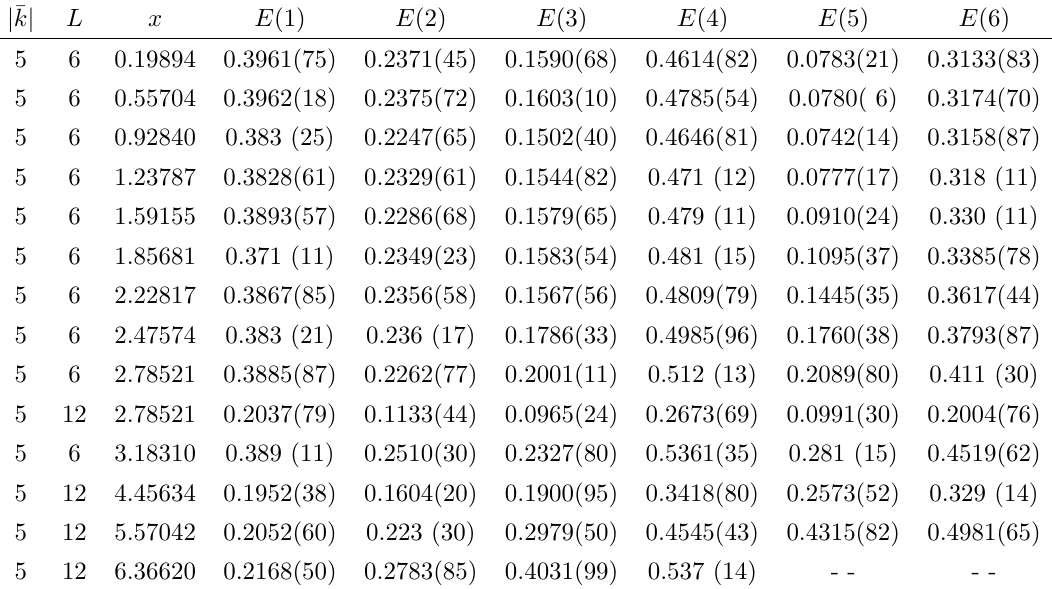
Table 8. SU(13) torelon energies (in lattice units). The states are labelled by the value of the electric (cid:13)ux modulus.